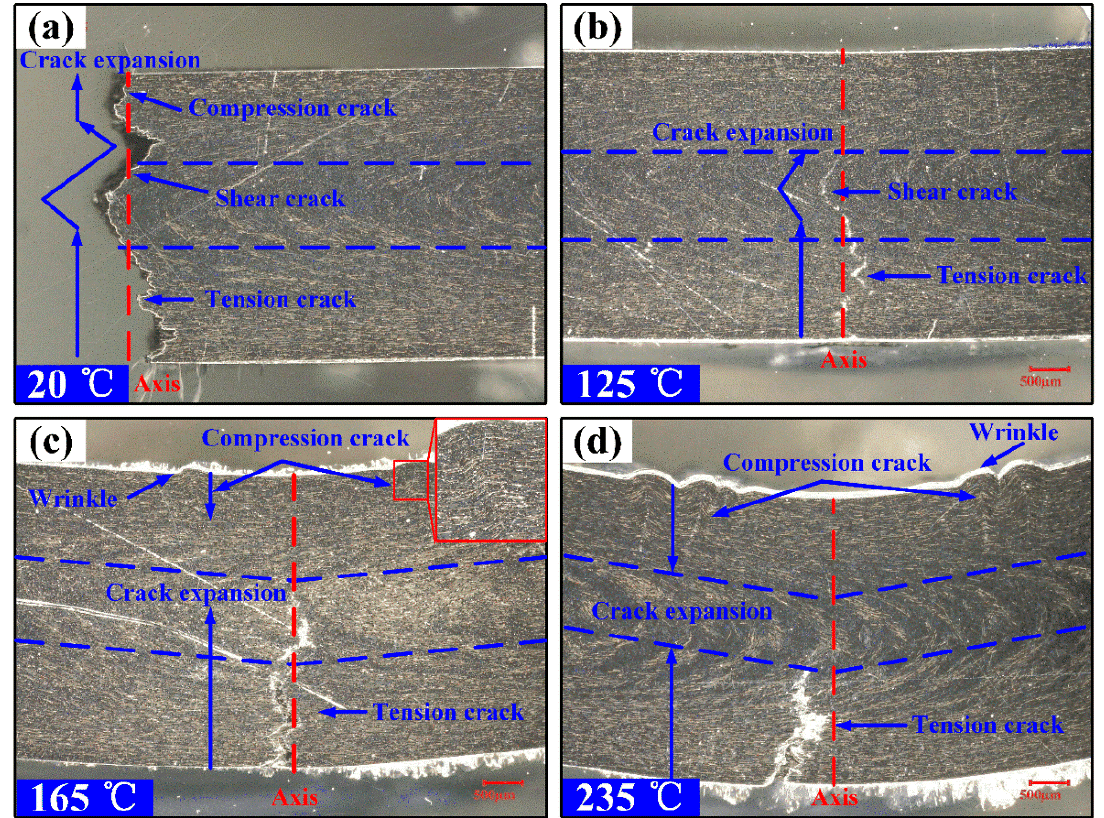
Figure 8. Micrographs of flexural failure specimens at various temperatures: ( a ) specimen failure at 20 °C, ( b ) specimen failure at 125 °C, ( c ) specimen failure at 165 °C, ( d ) specimen failure at 235 °C.